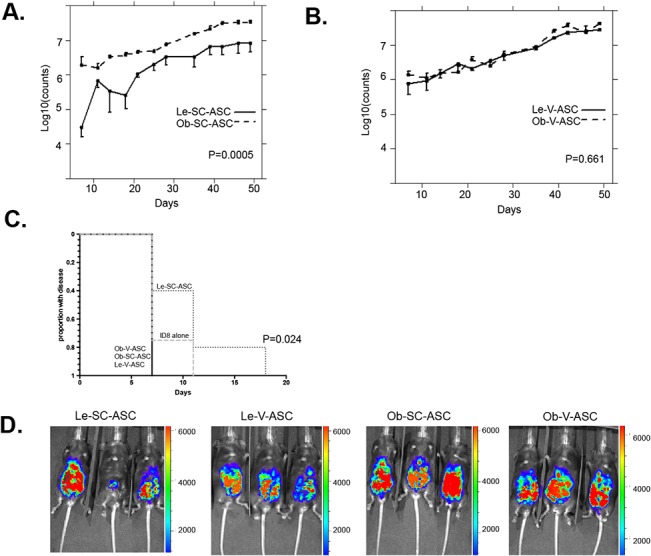
Ovarian tumor growth promotion by ASC.ASC were coinjected with luciferase-expressing ID8 tumor cells into C57BL/6 mice intraperitoneally (1:1 ratio, 106/each). N = 5 per group. A, Comparison of tumor burden measured by luciferase expression at abdominal side between Ob-SC-ASC and Le-SC-ASC groups. Error bar: 90% confidence interval. B, Comparison of tumor burden measured by luciferase expression at abdominal side between Ob-V-ASC and Le-V-ASC groups. Error bar: 90% confidence interval. C, Comparison of tumor initiation among groups. D, Luciferase signal measurement of abdominal side in the mice at day 46.